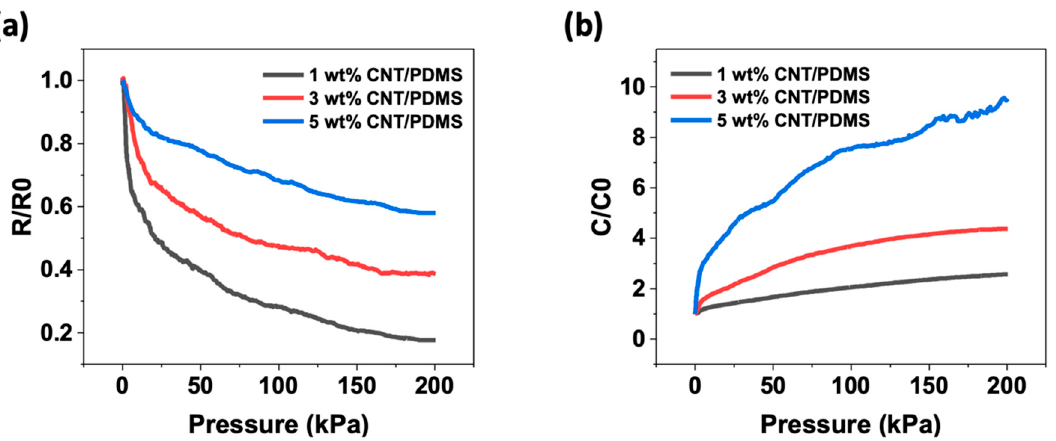
Figure 4. Normalized change in ( a ) resistance ( R / R 0 ) and ( b ) capacitance ( C / C 0 ) versus pressure with varying contents of CNTs in the composites.